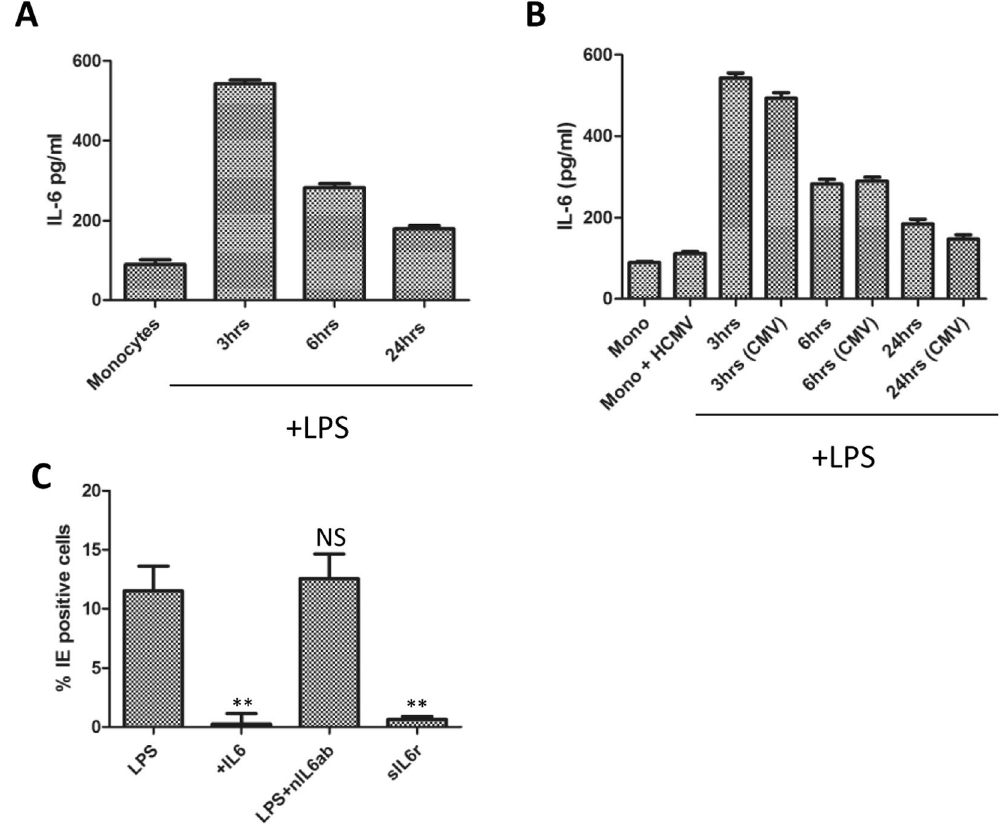
Figure 4. The differential effects of LPS are independent of IL-6 activity. ( A ) The supernatants from monocytes at 0, 3, 6 and 24 hours post LPS (500 ng/ml) stimulation were harvested and analysed for IL-6 production by ELISA n = 2. ( B ) The supernatants from uninfected monocytes (mono) or long term latently infected monocytes (Mono + HCMV) at 0, 3, 6 and 24 hours post LPS (500 ng/ml) stimulation were harvested and analysed for IL-6 production by ELISA n = 2. ( C ) Monocytes were stimulated with 500 ng/ml LPS, 50 ug/ml IL6, 500 ng/ml LPS plus nIL6 antibody, or 50 ug/ml soluble IL6 receptor (sIL6r) for 24 hours then infected with Merlin and then stained for IE protein expression 24 hpi. Nuclei were counter-stained with DAPI and infection rate calculated n = 3. ** p < 0.01; NS = non-significant difference when compared to infection of LPS